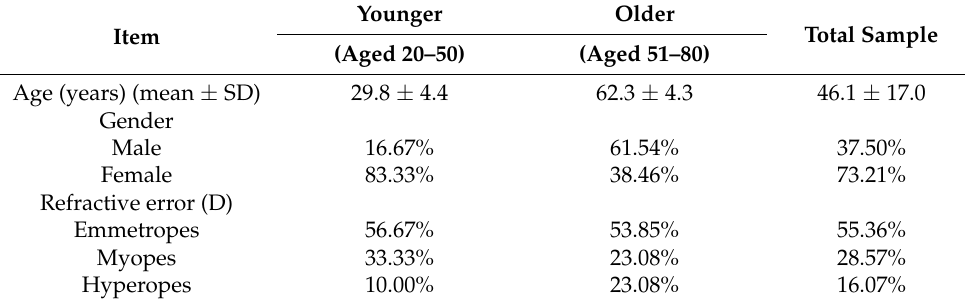
Table 1. Demographic and refractive situation of the